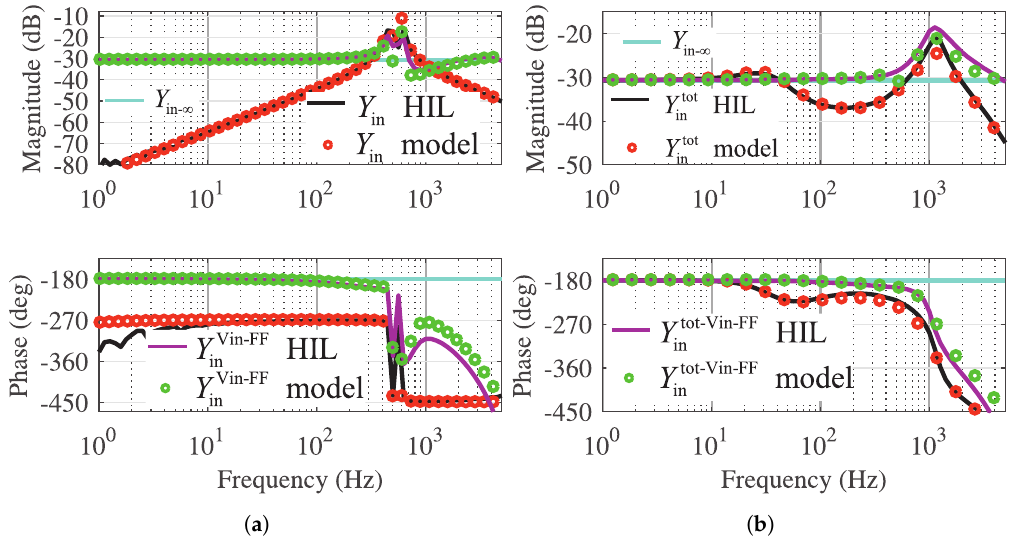
Figure 5. ( a ) Open-loop input admittance with and without the input voltage feedforward. ( b ) Closed-loop input admittance with and without the input voltage